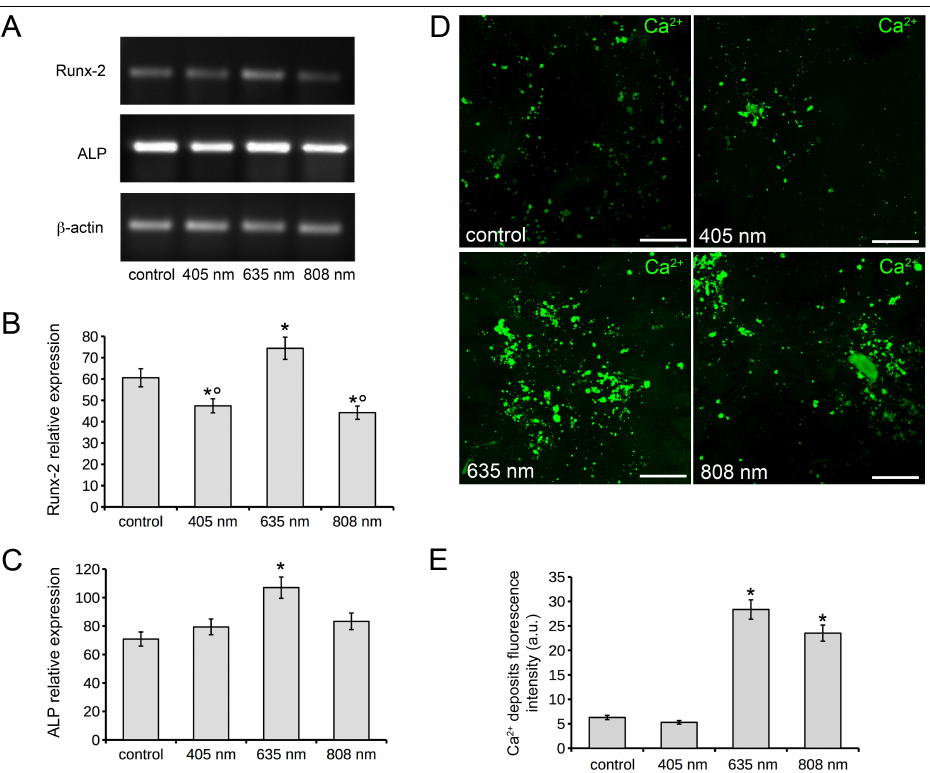
Figure 5. Effects of red, NIR and violet-blue on hMSC osteogenic differentiation. hMSCs subjected or not (control) to PBM treatments with 635 nm, 808 nm or 405 nm as reported in Table 1, were cultured for 7 and 18 days in osteogenic DM. ( A – C ) RT-PCR analyses of Runx-2 and ALP expression in the cells cultured for 7 days in DM in the indicated experimental conditions. ( A ) Representative agarose gels are shown. ( B , C ) Histograms showing the densitometric analyses of the ( B ) Runx-2 and ( C ) ALP bands normalized to β-actin. ( D ) Representative confocal fluorescence images of cells cultured in DM in the indicated experimental conditions for 18 days, fixed and stained with the fluorescent Osteolmage™ staining reagent (green) binding the hydroxyapatite portion of the bone-like nodule structures deposited by cells (Ca 2+ deposits). Scale bar: 50 µ m. ( E ) Histogram showing the densitometric analysis of the intensity of Ca 2+ deposits fluorescence signal performed on digitized images. The data are representative of at least three independent experiments, performed in triplicate. The values are expressed as mean ± S.E.M. Significance of difference: * p < 0.05 vs. control, ◦ p <